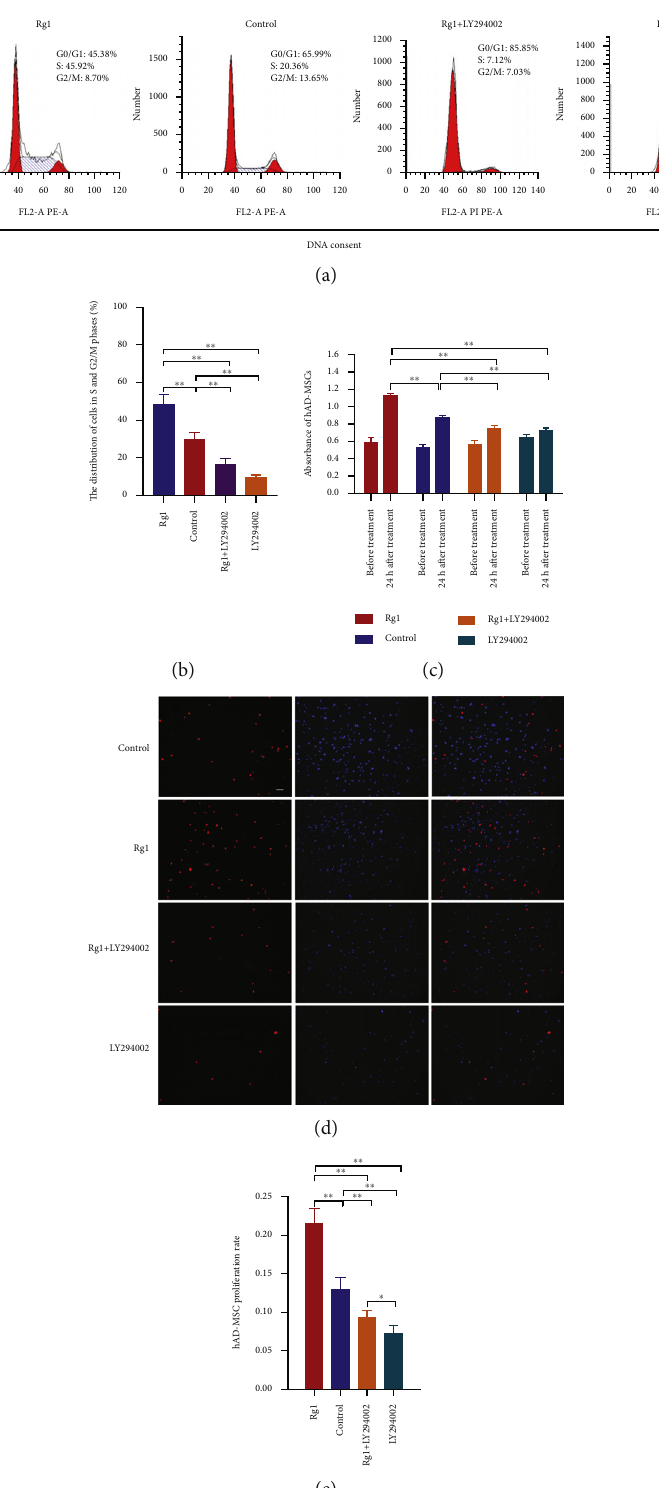
Figure 4: E ff ectsof ginsenoside Rg1 on the cell cycle phase distribution and proliferation of hAD-MSCs after blockingthe PI3K/AKT signaling. (a, b) The cell cycle phase distribution of hAD-MSCs was detected (a) and compared (b) by fl ow cytometry after pretreatment of hAD-MSCs with or without LY294002 for 1h followed by the treatment with or without Rg1 in the control, Rg1, Rg1+LY294002, and LY294002 groups ( n =3). (c – e) The proliferation of hAD-MSCs was detected and compared by CCK-8 (c) and EdU incorporation (d, e) assays after pretreatment of hAD-MSCs with or without LY294002 for 1h followed by the treatment with or without Rg1 in the control, Rg1, Rg1+LY294002, and LY294002 groups (100x) ( n =6). A representative sample of three independent experiments is shown. Scale bars=100 μ m. ∗ P < 0 : 05 and ∗∗ P < 0 : 01